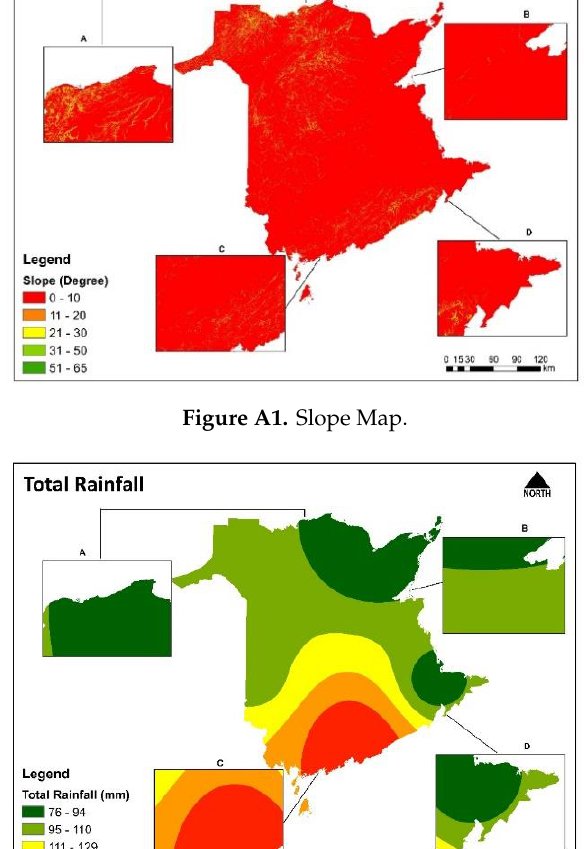
Figure A2. Total Figure A2. Total Rainfall.